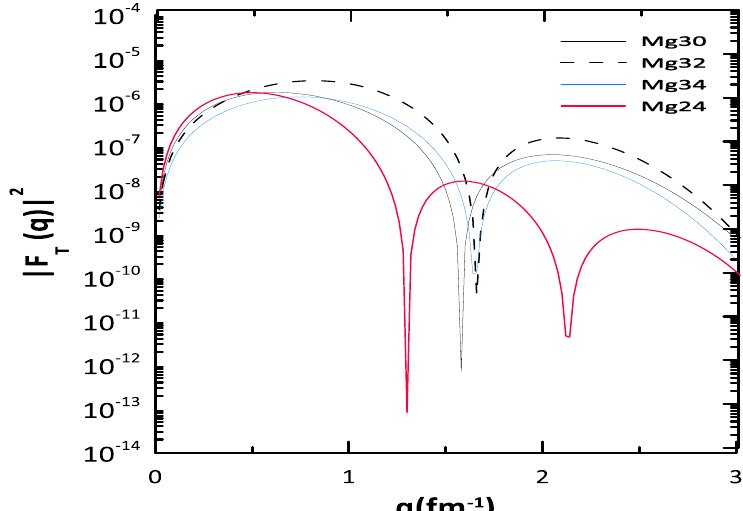
Fig. 11: The relation between moment transfer and transverses form factor for 24,30,32,34 Mg